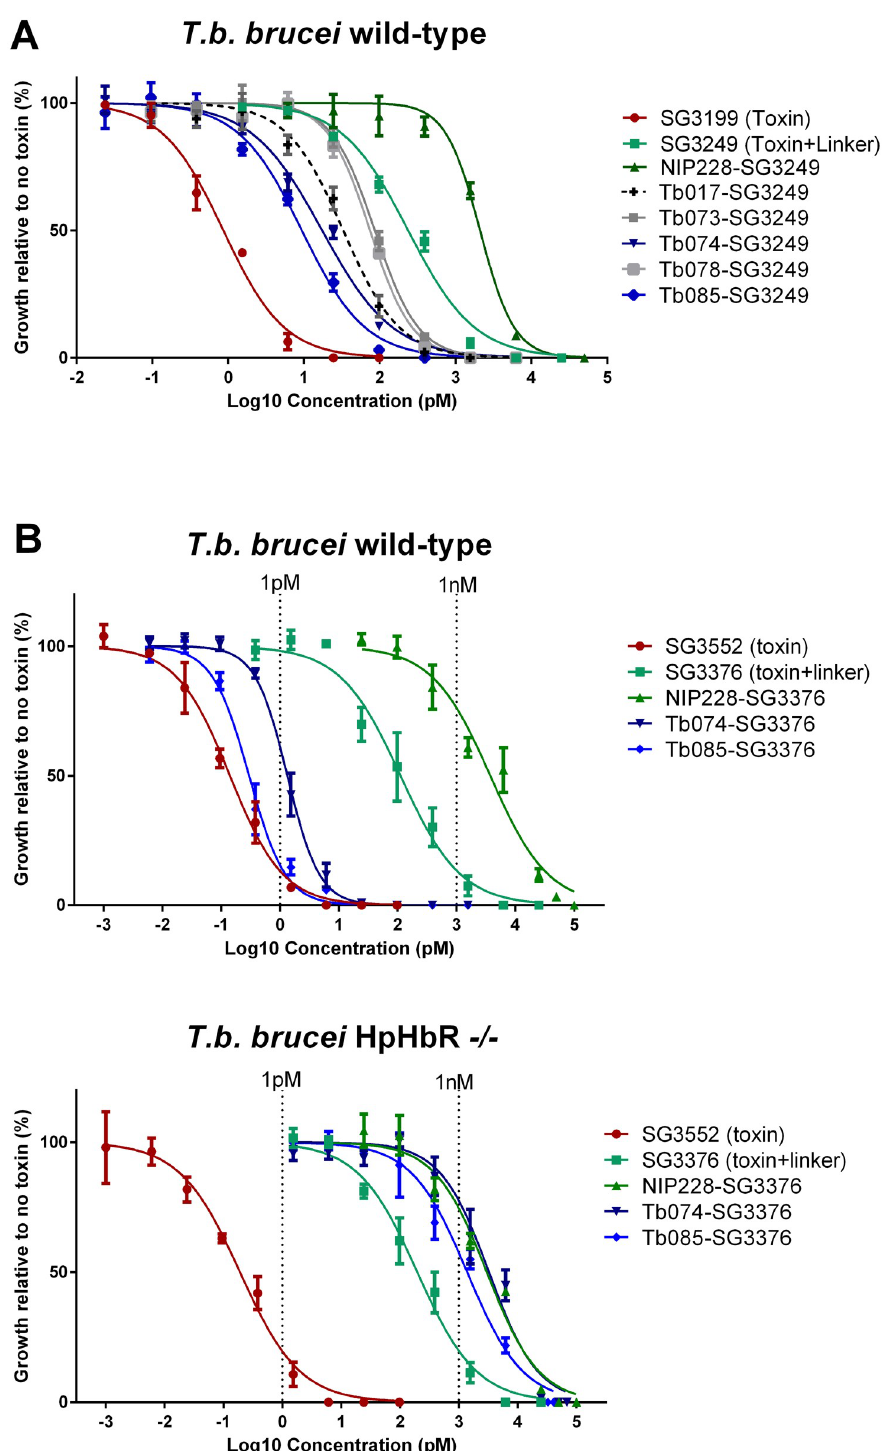
Fig 3. HpHbR antibody-PBD conjugates result in T . brucei cell death at low picomolar concentrations in vitro in a HpHbR-dependent manner. (A) Toxin SG3199 kills T . b . brucei wild type cells at sub-picomolar concentrations (IC 50 0.86 pM), killing activity is reduced by the addition of a linker (SG3249 IC 50 236.0 pM). Conjugation of SG3249 to a non-specific control antibody (NIP228) further reduces trypanosome killing activity to low nanomolar concentrations (IC 50 2.1 nM) whereas conjugation of SG3249 to antibodies that target the HpHbR increased killing activity to